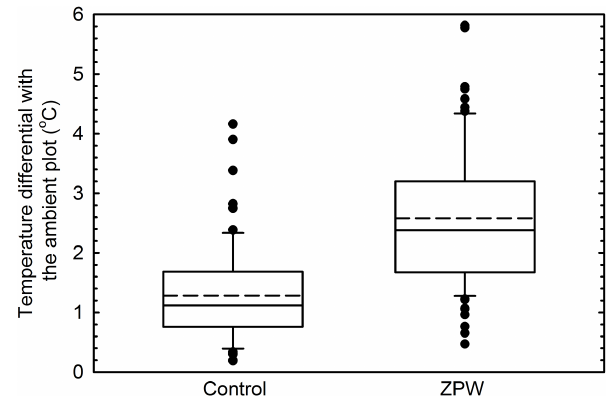
Figure 6. Tukey box plots showing the temperature differential of the mean daily air temperature between the control chamber and the ambient plot and between the ZPW chamber and the ambient plot. Warming in the ZPW chamber was double the control chamber. Box plots show the interquartile range (box), median (solid line) and mean (broken line). The whiskers show lowest and highest datum still within 1.5 × interquartile range of the lower and upper quartiles. Outliers are shown as black